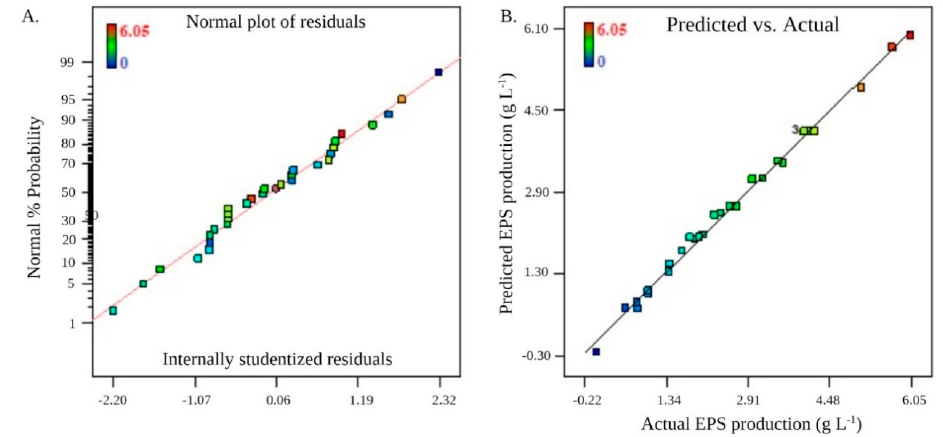
Figure 2. ( A ) Normal plot of residuals; ( B ) Predicted versus actual plot for EPS production. Contour plots (2-D) are a graphical representation that help to visualize the actual state of the regression optimization model to infer the relationship between parameters and response. Circular or elliptical curves indicate that corresponding parameters have not interacted, while hyperbolic and plateau-shaped curves denote interaction. In this study, the relationship between independent parameters and EPS production was ex- plained by a 2-D contour plot of the response surface, while keeping others at zero level (coded value) [28]. In Figure 3a, it can be observed that the maximum yield of EPS was 4.6 g L − 1 when the concentration of glucose and yeast extract were both 20 g L − 1 , while the minimum EPS yield was 0.1 g L − 1 with high glucose and yeast extract concentrations (50